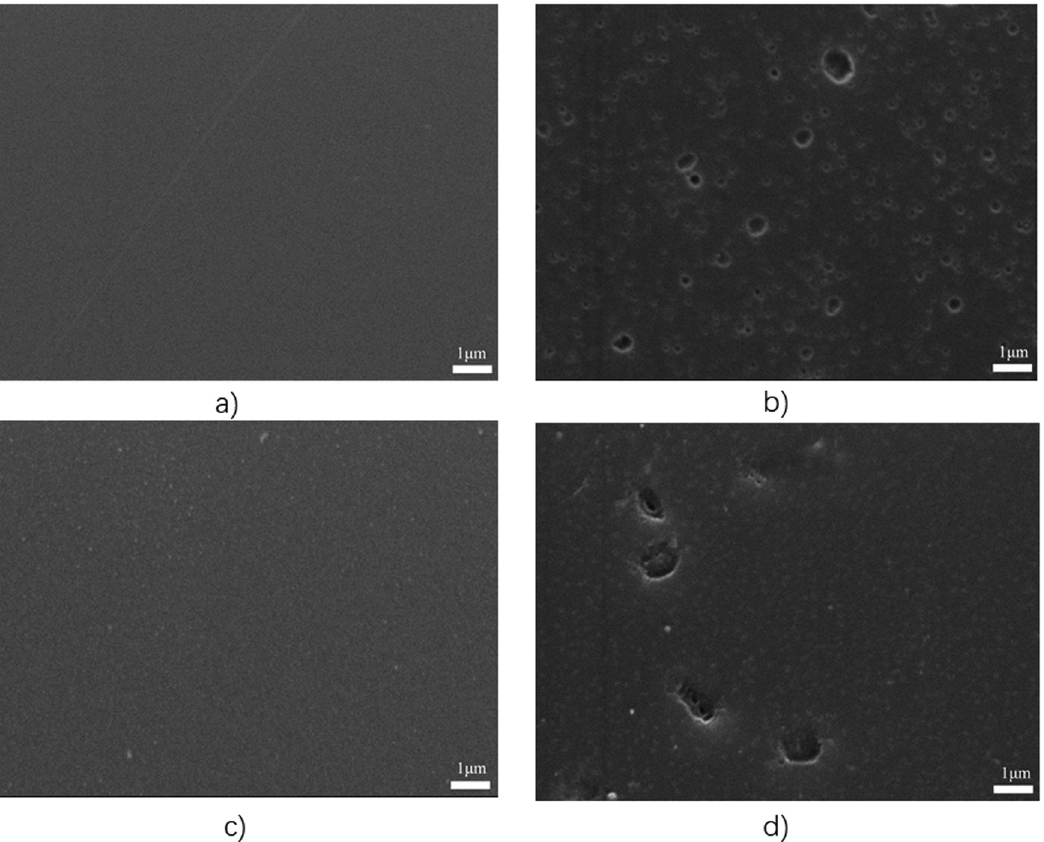
Figure 9: SEM images of cured PNR and RS: ( a ) cured RS, ( b ) cured RS/ageing at 350°C, ( c ) cured PNR and ( d ) cured PNR, aging at